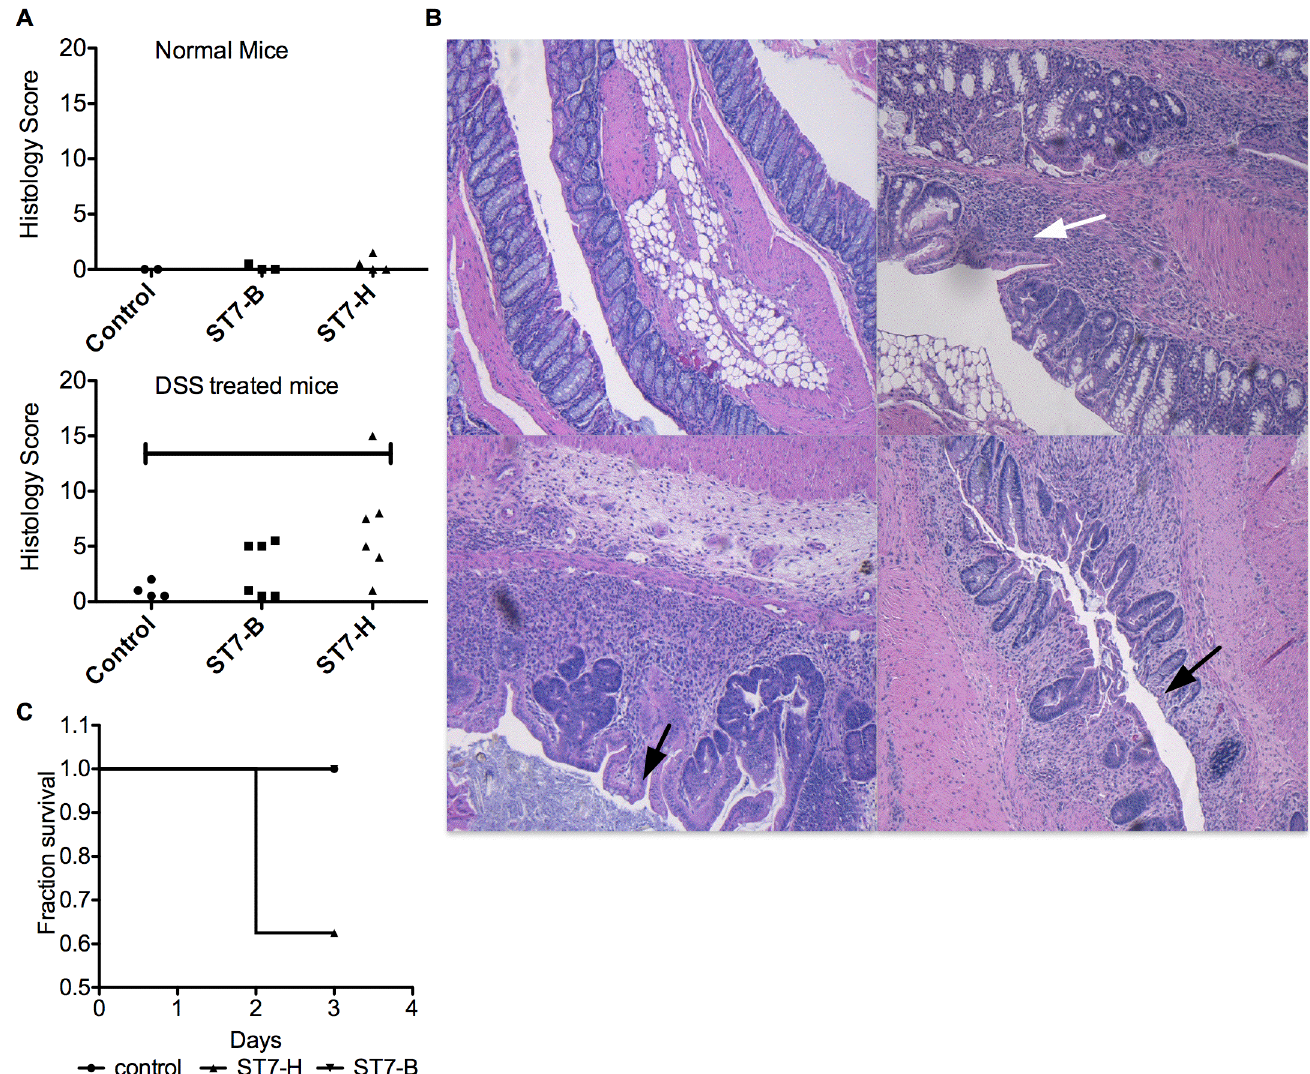
Fig 3. Histopathological examination of mice infected with Blastocystis spp. (A) Tissue damage assessed by histological scoring showed little evidence of damage in normal mice. Significant damage was seen in DSS-treated mice infected with ST7-H compared to sham surgical controls. * p < 0.05. (B) Representative histological images of tissue damage in distal colon of infected DSS-treated mice. clockwise from top left (1) DSS treated mouse control (2) & (3) ST7-H infected mice with moderate crypt loss (black arrow) and inflammatory cell infiltration (white arrow) (4) ST7-B infected mouse with moderate crypt loss (black arrow) and occasional inflammatory infiltration (C) Survival analysis showed ST7H had higher mortality (p = 0.17) while ST7B (p = 1) was similar to sham surgical controls but this did not approach statistical significance.